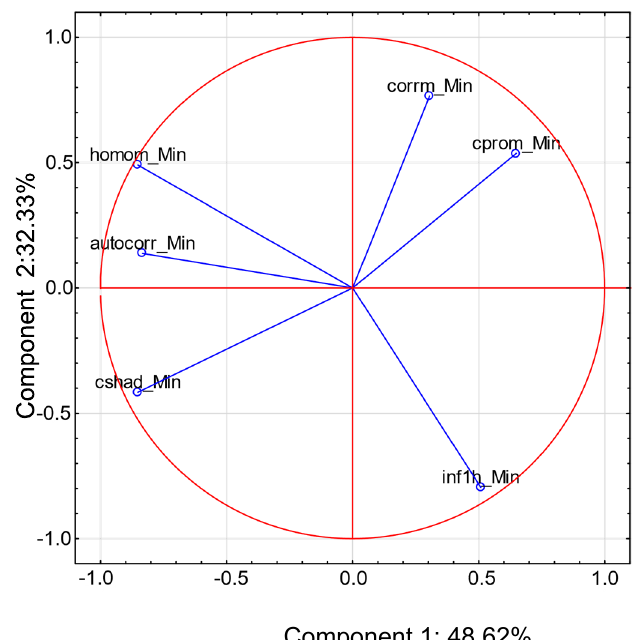
Figure 5. Projection of selected GLCM texture discriminants calculated in the MATLAB environment onto the principal component factor plane generated using Statistica 13.3.